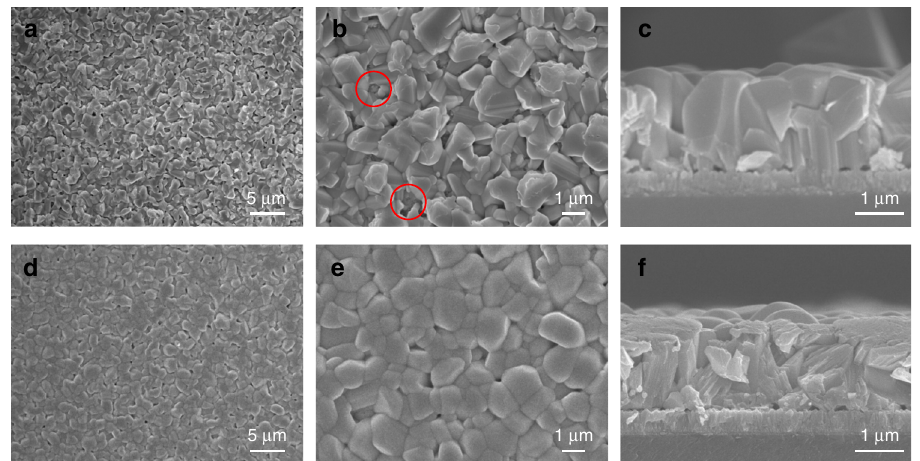
Fig. 1 Microstructures and crystallographic orientation of Sb 2 Se 3 thin fi lms. a – f SEM images of a – c slow-cooling Sb 2 Se 3 and d – f fast-cooling Sb 2 Se